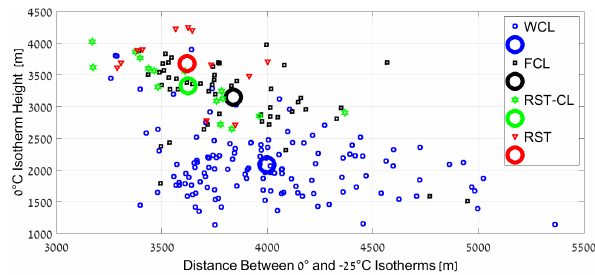
Figure 2. The 0 ◦ C isotherm height above sea level as a function of the depth (thickness) of the atmospheric layer between 0 and − 25 ◦ C (m). Results are based on geopotential height of the 0 and − 25 ◦ C isotherms using the GDAS database for the area between 32–33 ◦ N and 34–35 ◦ E. Centroids for the four subsets are marked with circles.